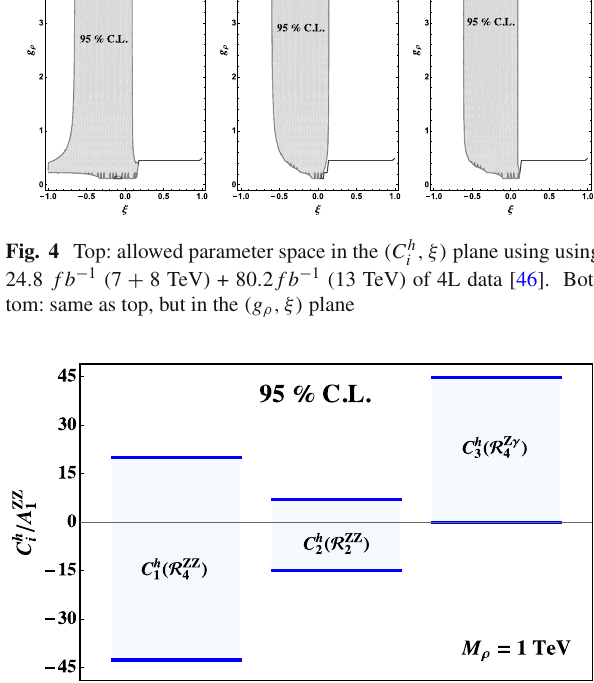
Fig. 5 Fits to C h limits on A i shown in Table 2